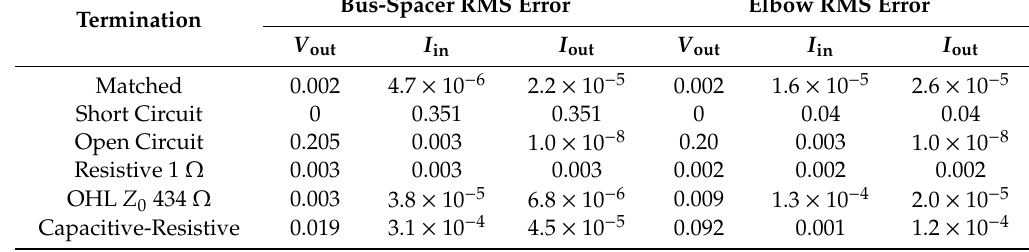
Table 2. Root mean square (RMS) error comparison of pole-residue model with ADS representation.